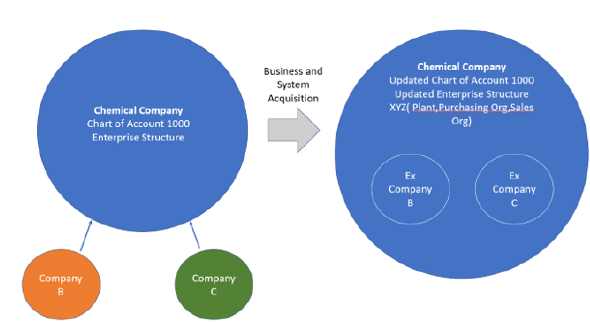
Figure 1: Company B and Company C Acquisition by Chemical Com- pany